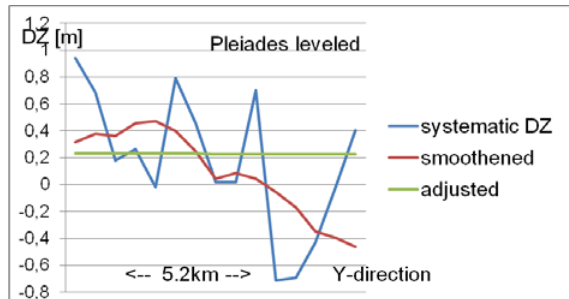
Figure 14. Systematic height errors in Y-direction, Zonguldak, leveled Pléiades DSM against reference DTM